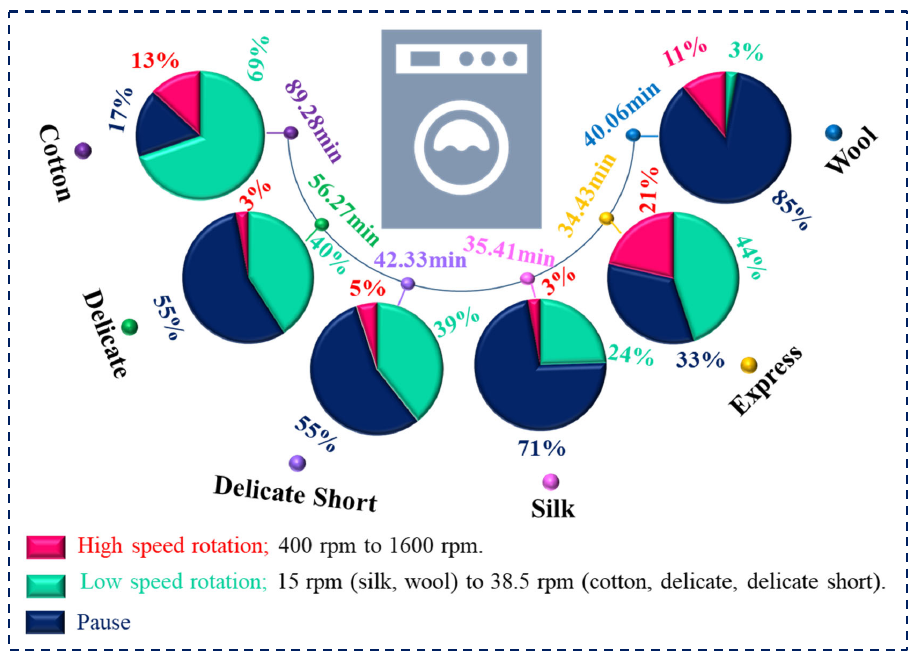
Figure 9. Different domestic laundry programs and their duration (min) configuration.